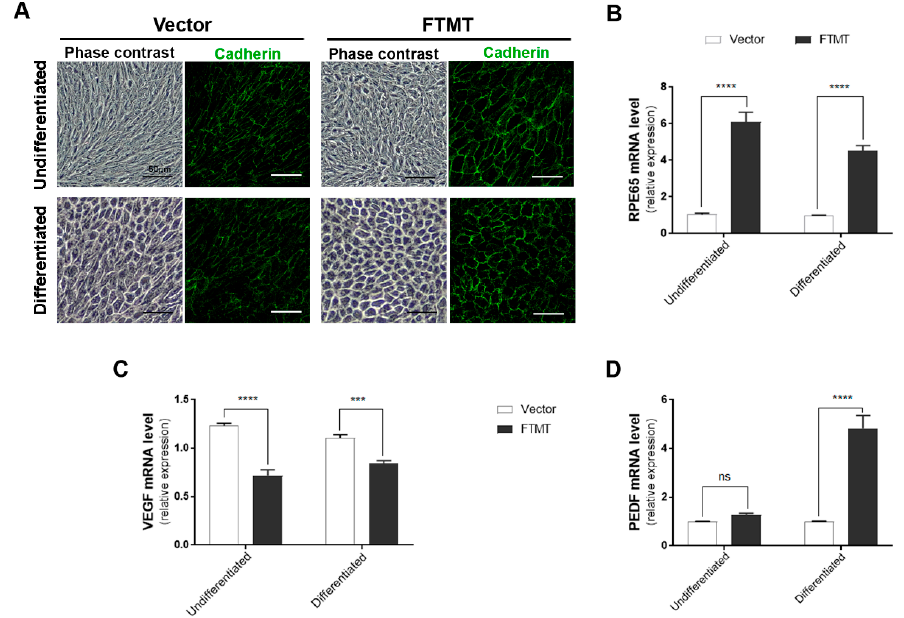
Figure 6. Features of FTMT stably overexpressing undi ff erentiated and di ff erentiated ARPE-19 cells: ( A ) Morphology (phase contrast) and pan-cadherin immunocytochemistry of control vector transfected and FTMT stably transfected ARPE-19 clones. Scale bars represent 50 µ m. ( B ) FTMT overexpressing ARPE-19 clone (undi ff erentiated and di ff erentiated) expressed significantly higher levels of RPE65 mRNA compared to vector clone. ( C ) FTMT-overexpressing clone (undi ff erentiated and di ff erentiated) expressed significantly lower levels of VEGF mRNA. ( D ) FTMT-overexpressing clone (di ff erentiated) expressed significantly higher levels of PEDF mRNA. Comparison of relative expression was made between undi ff erentiated vector and undi ff erentiated FTMT clone or between di ff erentiated vector and di ff erentiated FTMT clone. Values do not reflect di ff erences between undi ff erentiated and di ff erentiated cells. Data were analyzed by one-way ANOVA with Sidak’s test, *** p < 0.001, and **** p < 0.0001, n = 4). Results are shown as the mean ±